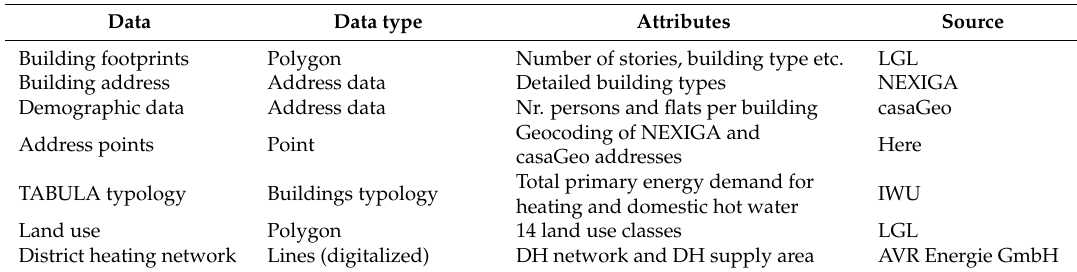
Table 1. Consulted